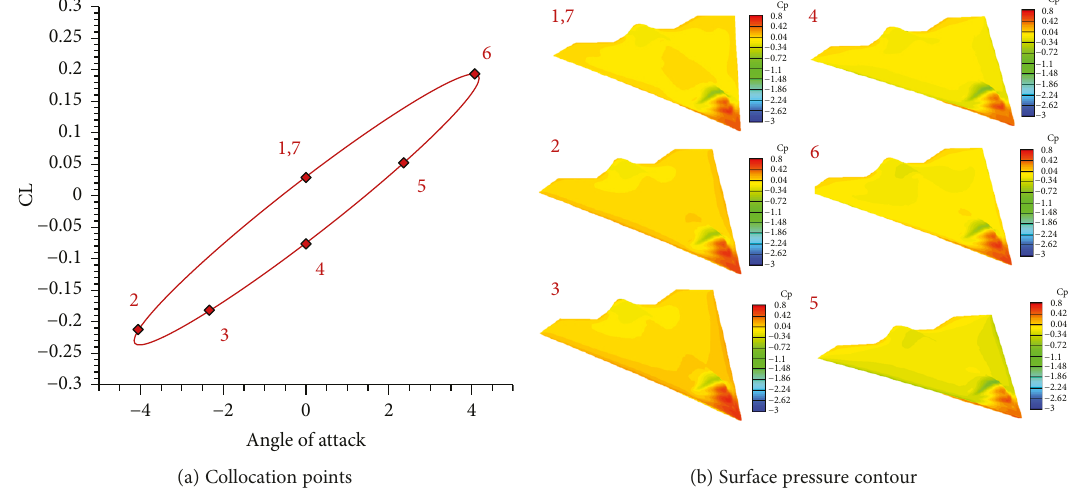
Figure 10: Surface pressure contours of ICE con fi guration at di ff erent collocation points. Table 4: Dynamic derivatives for ICE con fi guration from normal force. Sti ff ness (in-phase) Damping (out-of-phase) Time-accurate